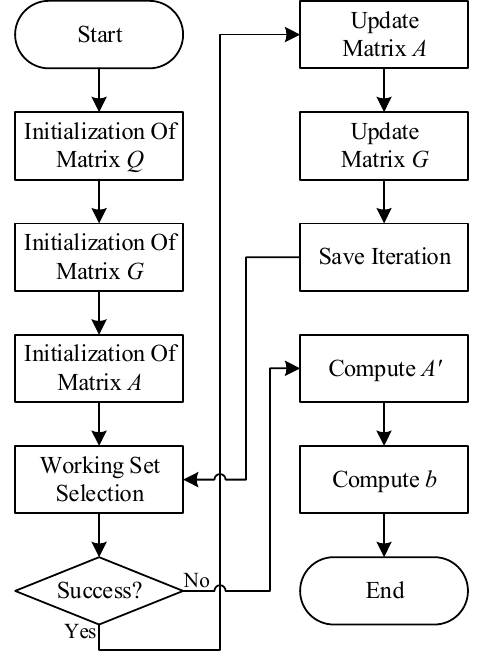
Figure 4. Flow chart of the ε -SVR training method.